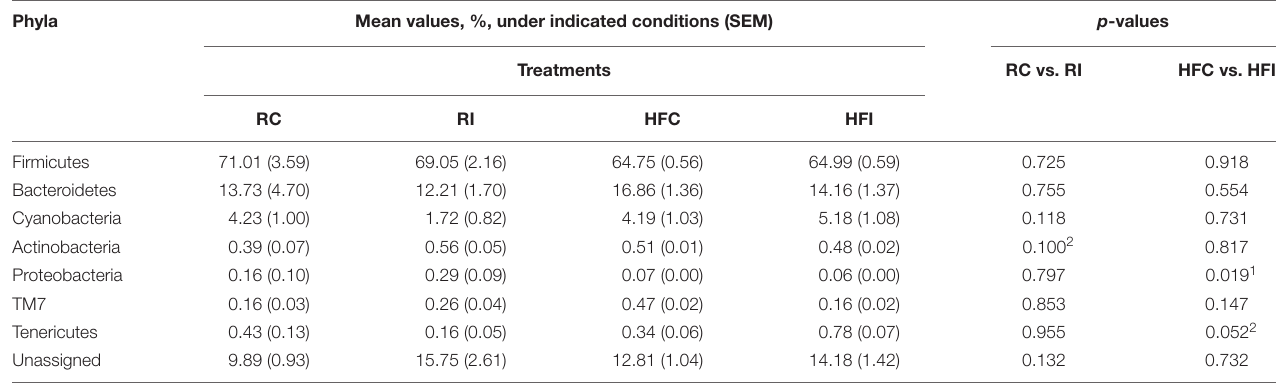
TABLE 3 | Average percentages of bacteria phyla in the cecal content. Phyla Mean values, %, under indicated conditions (SEM) p -values Treatments RC vs. RI HFC vs.